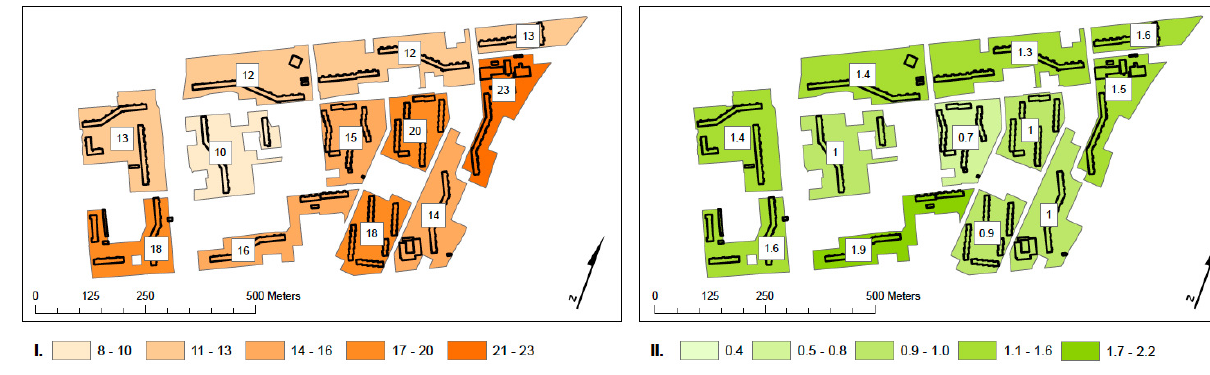
Figure 4. Results of analysis of (I) BCR and (II) FAR. Table 2. Results of calculations of FAR, BCR, and GAR for both